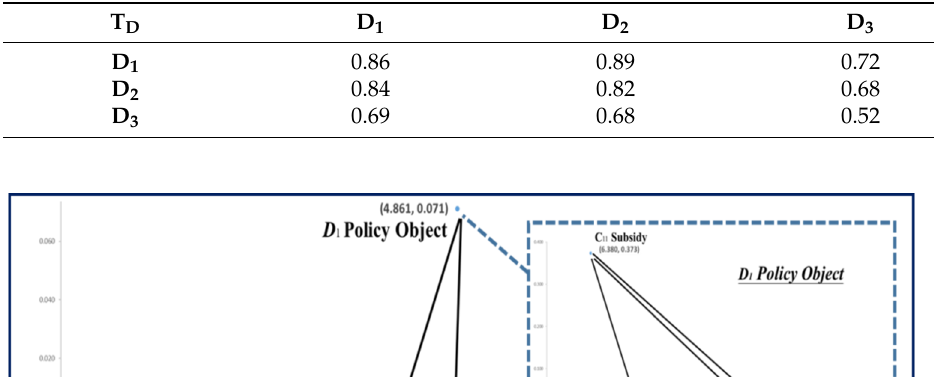
Table 5. Total influence matrix of dimensions T D .